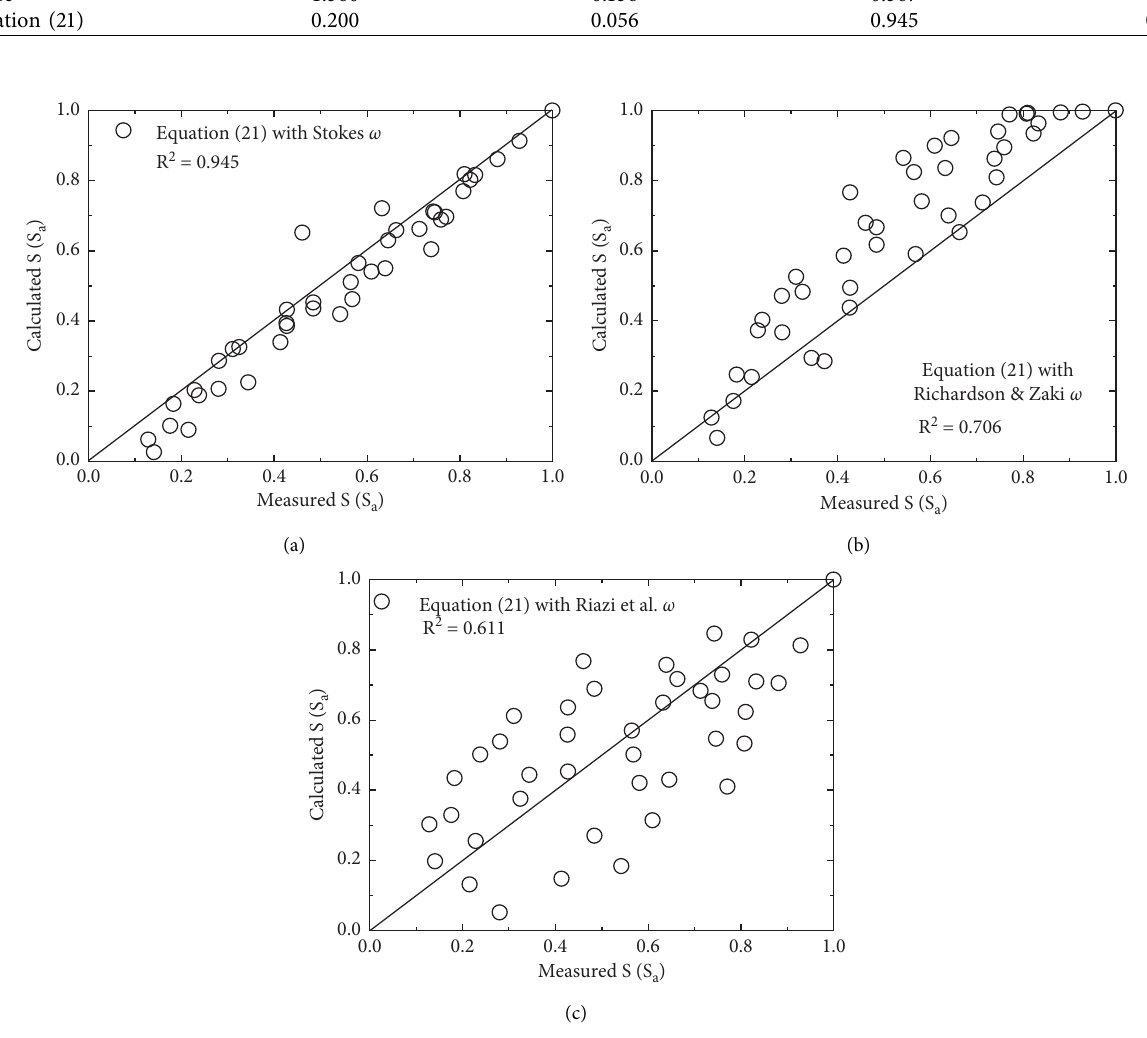
Figure 8: Verifcation of sediment